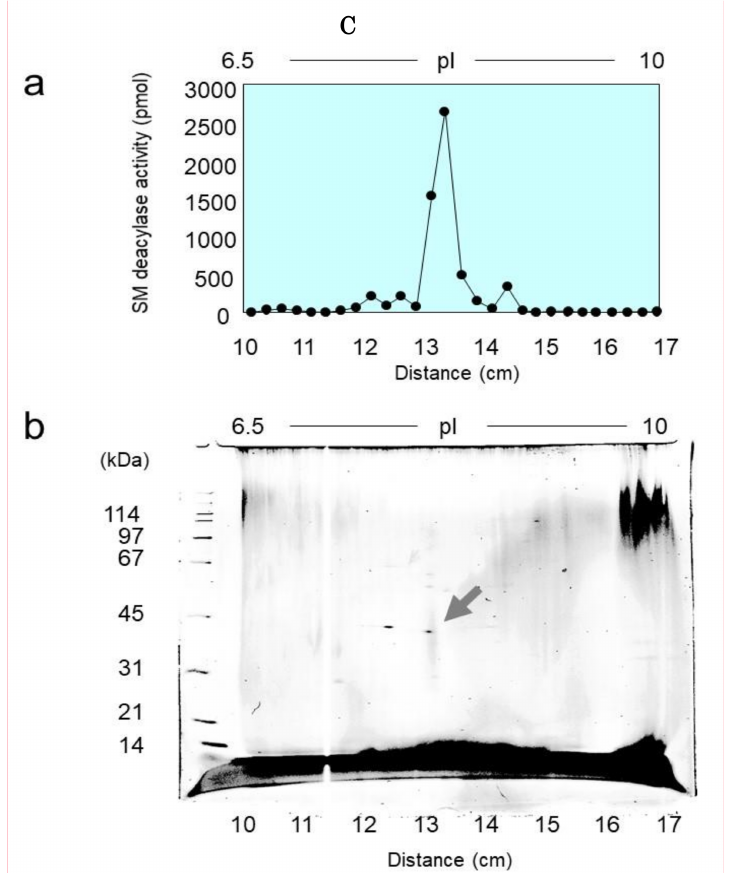
Figure 2. ( A ): SDS-PAGE of SM deacylase active fractions in each purification step. Aliquots of SM deacylase active fractions after each purification step were collected and analyzed by 12.5% SDS-PAGE, followed by staining with SYPRO Ruby and visualization of fluorescence using a Typhoon-9400